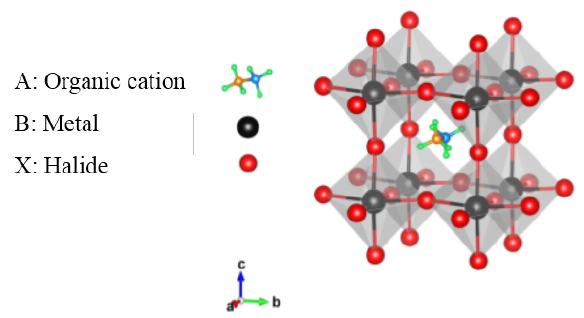
Figure 1: Crystalline structure of the hybrid perovskite [4]